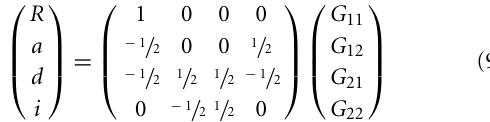
FIGURE 2 | Individual-referenced genetic effects proposed in the text for a one-locus, two-allele, imprinted genetic system. As in the previous figure, the alleles are A 1 and A 2 , with the variants due to imprinting being ¯ A ¯ A 1 and 2 . Although no population frequencies are considered in this figure, the notation of the axes is kept consistent with the other figures, with p 2 = 0 . 5 indicating the heterozygotes. Also the genotypic values (black discs) are mostly kept, with the one of the heterozygote of Figure 1 ( A 1 A 2 , G 12 = 5) being the midpoint between the ones of the two heterozygotes in this figure ( A 1 ¯ A 2 and A 2 ¯ A 1 , G 12 = 4 and G 21 = 6, respectively). (A) The two-dominances model is a natural extension of the non-imprinted case that consists in introducing two dominance parameters, one for each heterozygote. As well as in the non-imprinted case, the dominance effects measure departures of the heterozygotes from their additive expectation (gray disc). (B) The imprinting-effect model keeps one only dominance effect that accounts for the departure of the midpoint between the two heterozygotes (upper gray disc) and the midpoint between the homozygotes (lower gray disc), and adds up an imprinting effect for accounting for the distance between the heterozygotes and their midpoint (upper gray disc). Thus, the dominance effect in this model coincides with that of a non-imprinted model (i.e., the one that would be obtained if imprinting was just disregarded).